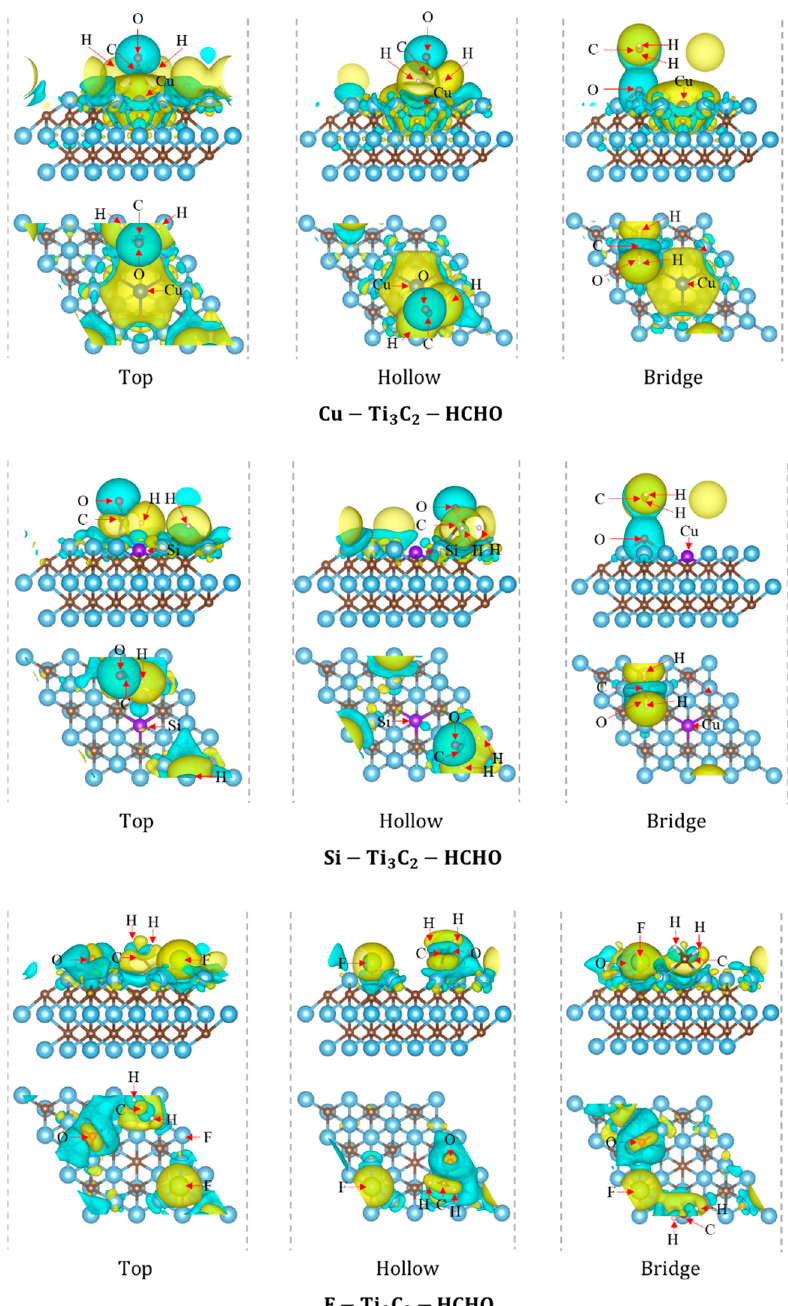
Figure 5. Differential charge density diagram of HCHO at different adsorption sites on Cu-Ti 3 C 2 , Si-Ti 3 C 2 and F-Ti 3 C 2 surfaces. (Iso Ti 3 C 2 surface value is 0.002 e/Å 3